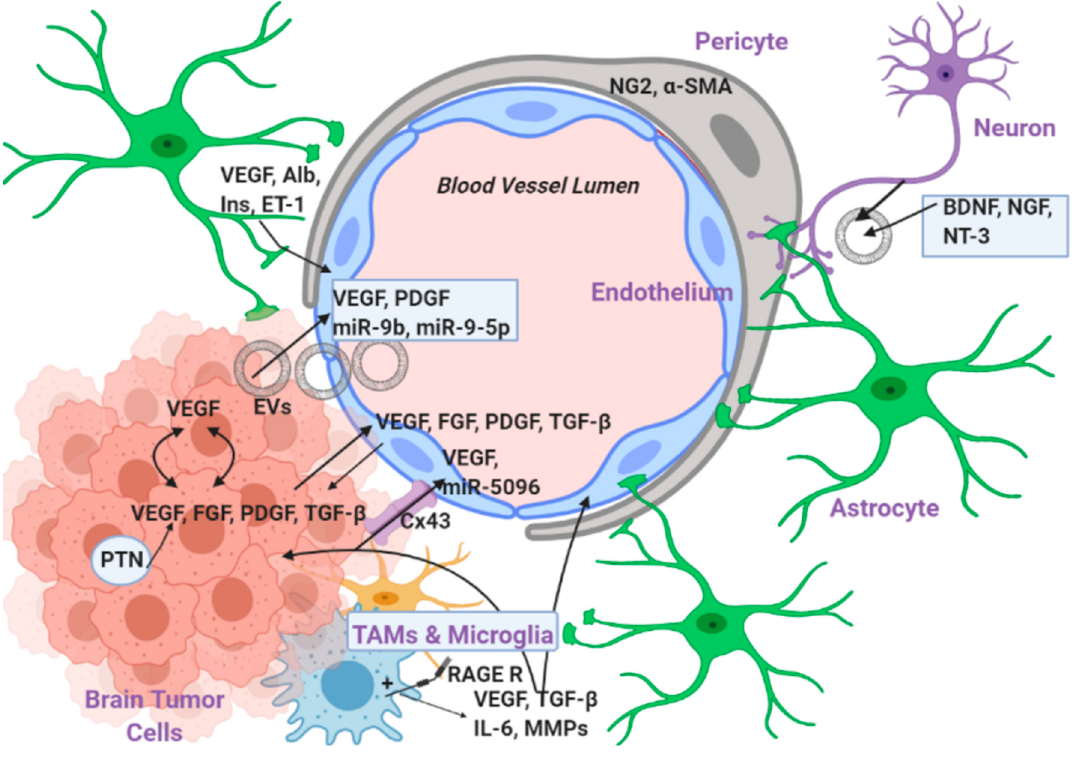
Figure 2. Levels of interaction between the endothelial and the tumor cells. The interaction happens on three different levels: (a) secreted factors, (b) gap junctions, and (c) intermediate cells. The secreted factors are derived either from the tumor or the endothelial cells and there is a reciprocal relationship between them. (a) Brain tumor cells produce and secrete VEGF, FGF, PDGF, and TGF- β that act upon the endothelial cells and induce angiogenesis with mechanisms discussed in Section 2. Moreover, the tumor cells secrete extracellular vesicles (EVs) that contain secreted protein factors and microRNAs that are also positively correlated with the induction of angiogenesis. Note also that there is a positive feedback loop mechanism between pleiotrophin (PTN) and VEGF production on the tumor cells. (b) There is also direct interaction between the tumor and endothelial cells in the brain via connexins such Cx43. Cx43 facilitates the transportation of microRNAs and proteins like VEGF from the tumor to the endothelial cells and therefore is directly involved in the induction of angiogenesis. (c) Many types of surrounding intermediate cells also play a crucial role in the communication between the endothelial and the tumor cells. Pericytes promote vascular maturation by expressing NG2 and α -SMA. It is important to note that the interaction between the pericytes and the endothelial cells contributes to the formation of junctions between the endothelial cells and triggers signaling that leads to the recruitment of either resident or peripheral immune cells, which can also support angiogenesis (see discussion about TAMs below). Astrocytes secrete factors that promote and support angiogenesis and vessels growth such as VEGF, albumin (Alb), insulin (Ins) and endothelin-1 (ET-1). Additionally, the resident microglia and the tumor associated macrophages (TAMs) which reside locally and have an M2 tumor-promoting phenotype play a very important role in supporting tumorigenesis and angiogenesis via their receptor RAGE1, whose activation triggers the secretion of VEGF, matrix metalloproteinases (MMPs), TGF- β , and IL-6. Finally, the surrounding tumor neurons seem to also affect the endothelial–tumor cell interaction since they secrete factors such as BDNF, NGF, and NT3 which are all not only angiogenic but also facilitate endothelial cell survival and vessel stabilization.